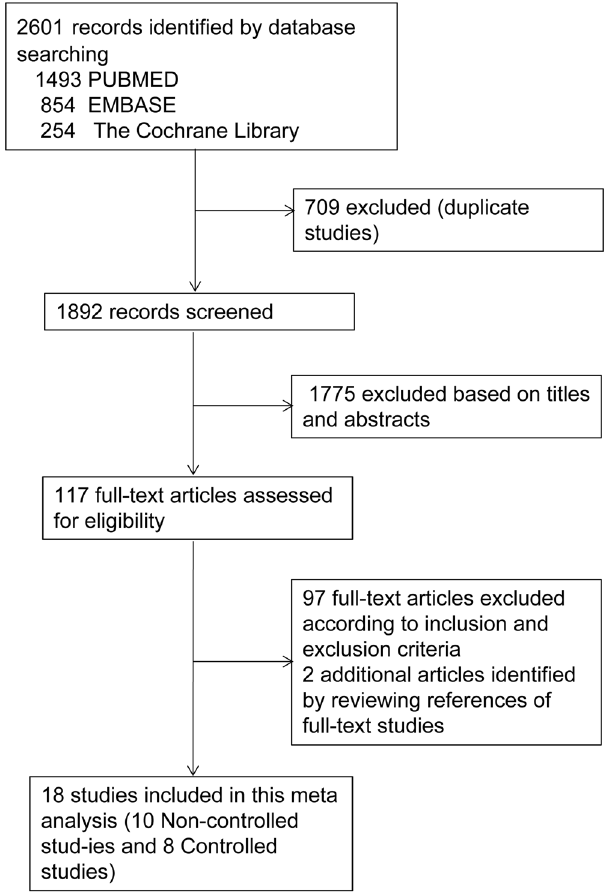
Figure 1. Flow diagram of study identification and